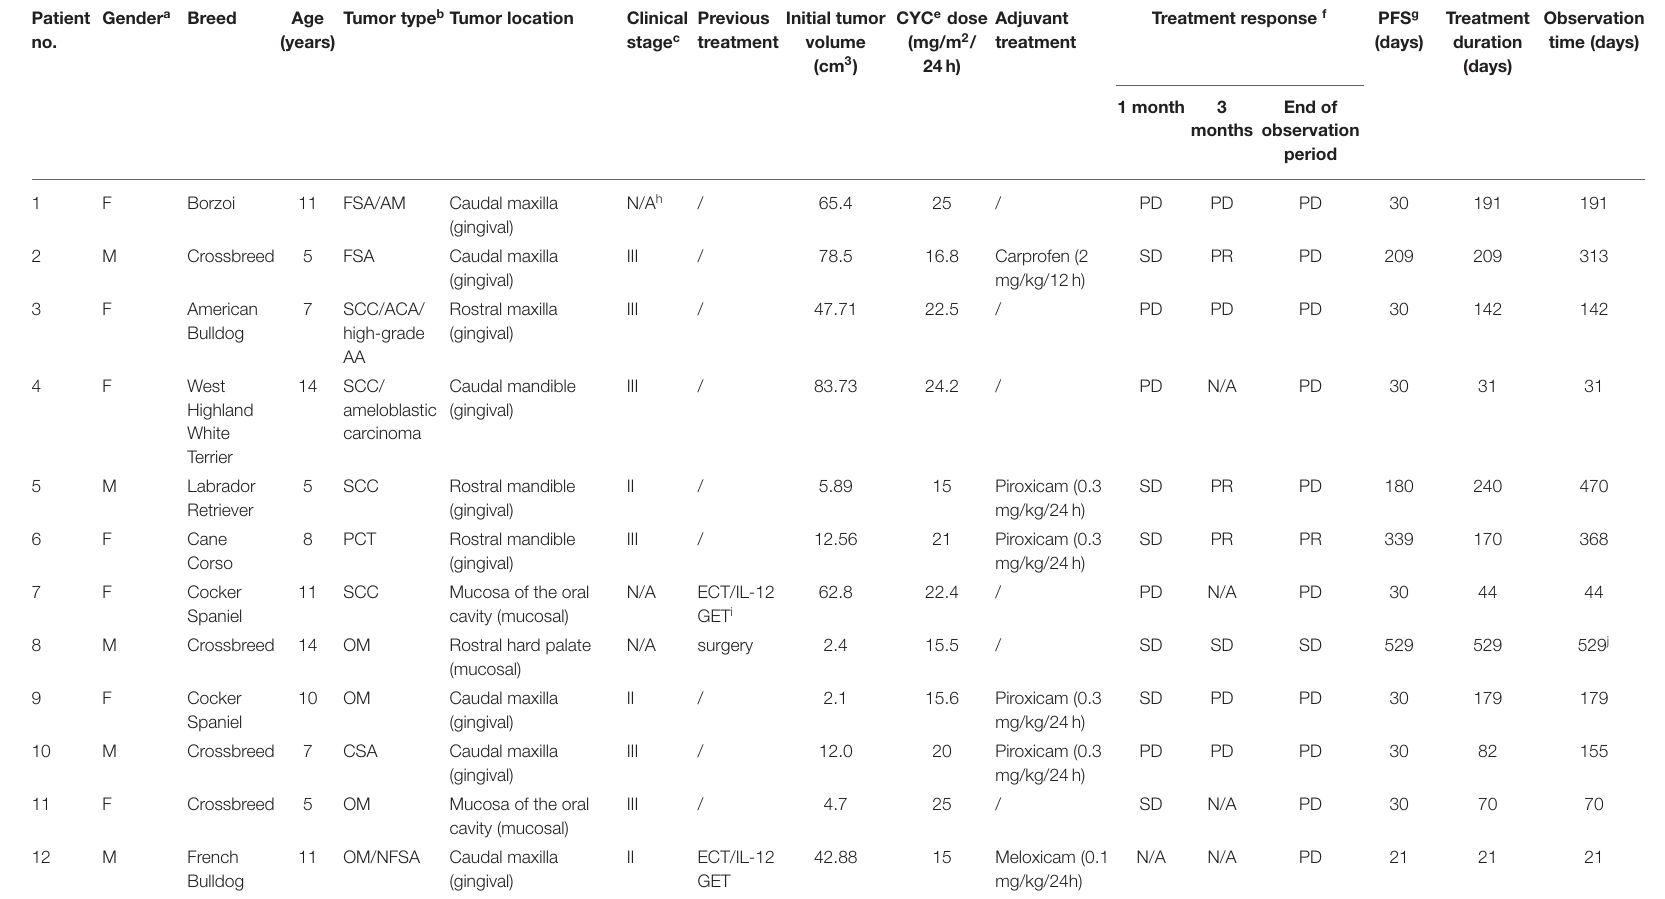
TABLE 1 | Patient data and treatment response. Patient